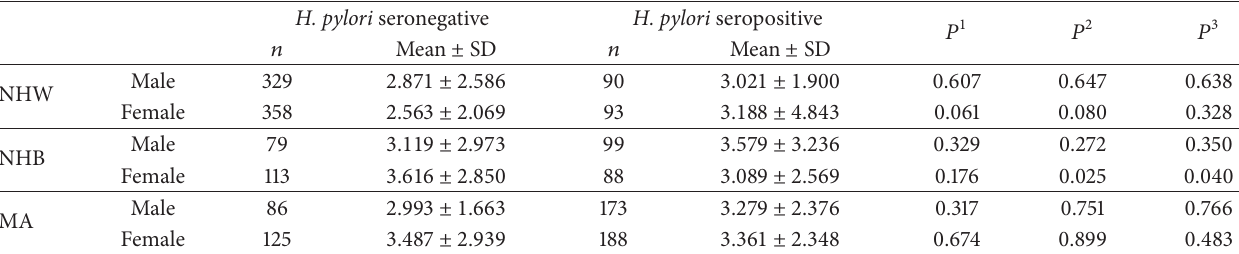
Table 4: Comparison of HOMA-IR based on H. pylori